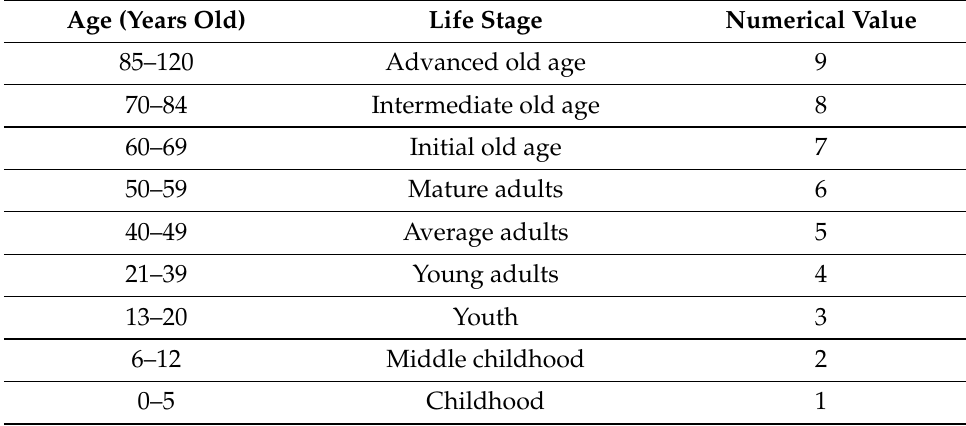
Table 3. Age factor pre-processing, taken from